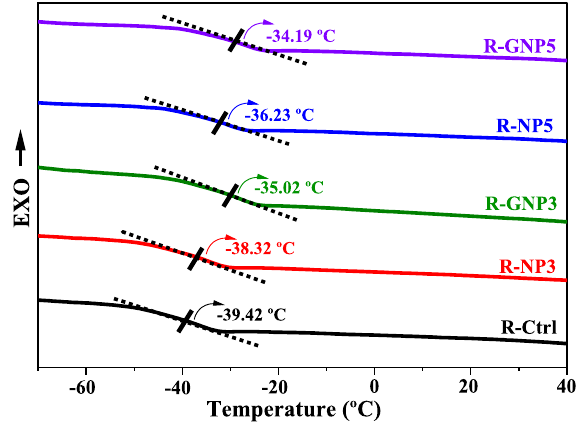
Figure 12. Glass transition temperature of the NBR samples based on DSC